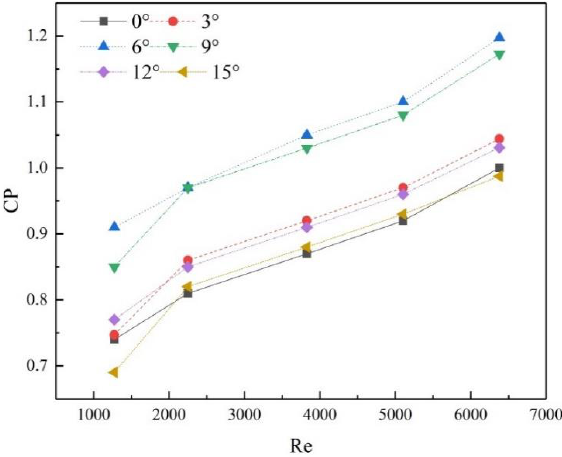
Figure 15. Comprehensive performance of models with different taper angles.